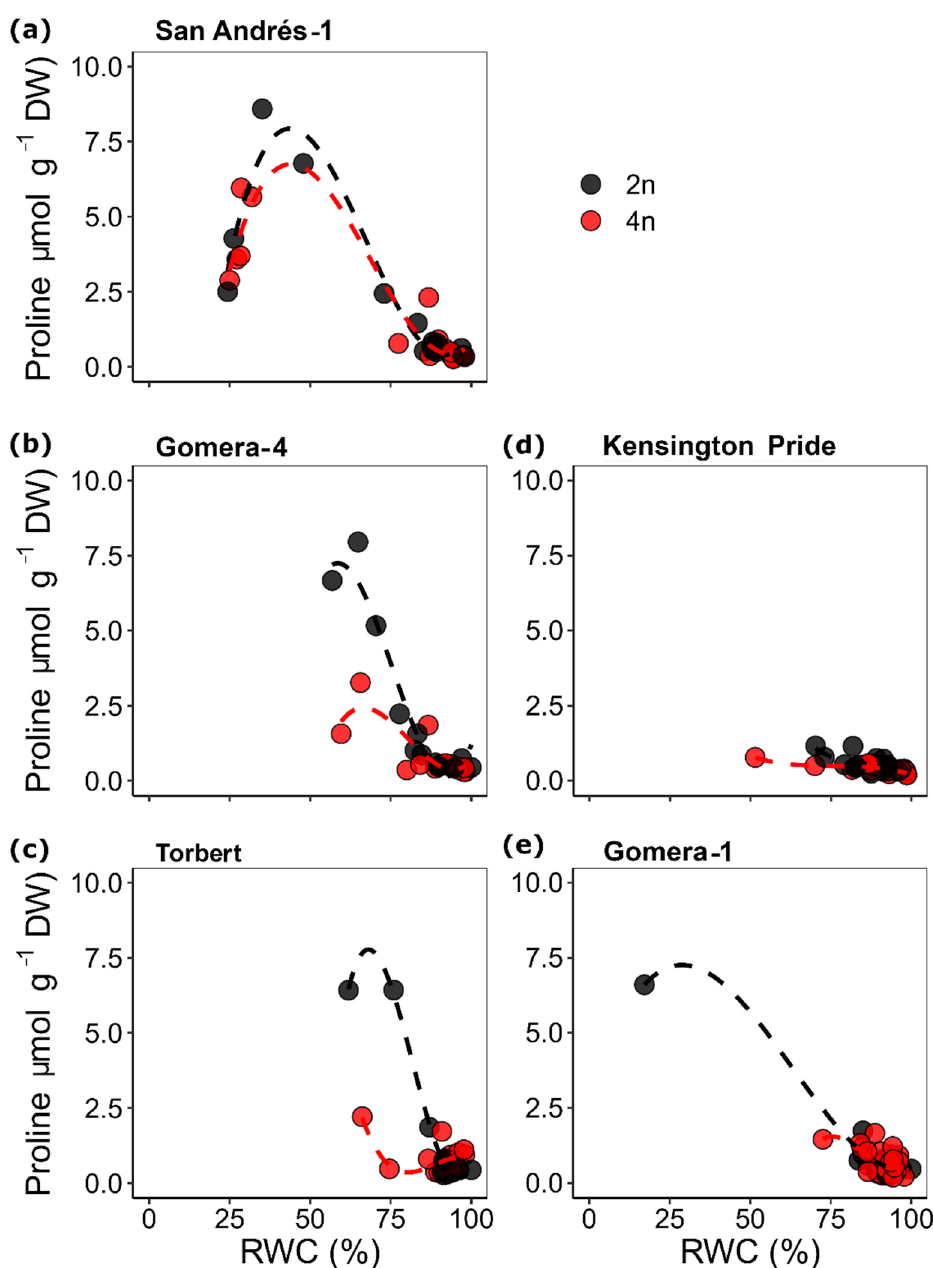
Figure 6. Relationship between relative water content (RWC) and proline for diploids (black circles) and tetraploids (red circles) of the five studied cultivars: ( a ) ‘San Andrés-1’, ( b ) ‘Gomera-4’, ( c ) ‘Torbert’, ( d ) ‘Kensington Pride’, and ( e ) ‘Gomera-1’. Dashed line indicates the non-linear fitting for diploids and tetraploids.